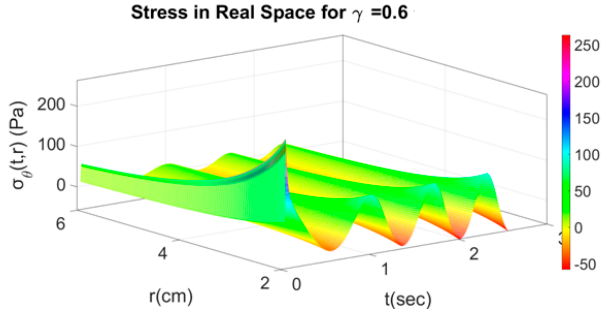
Figure 10. Distribution of the radial stress σ r ( t , r ) in the initial space for γ = 0.6.